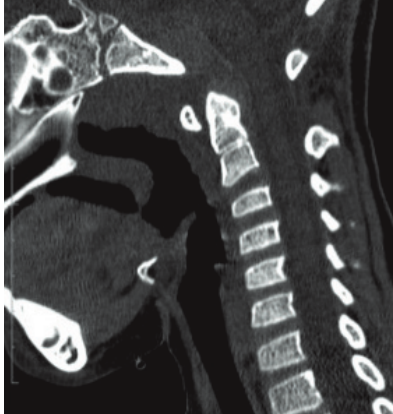
Fig. 3. Sagittal CT reformat of the